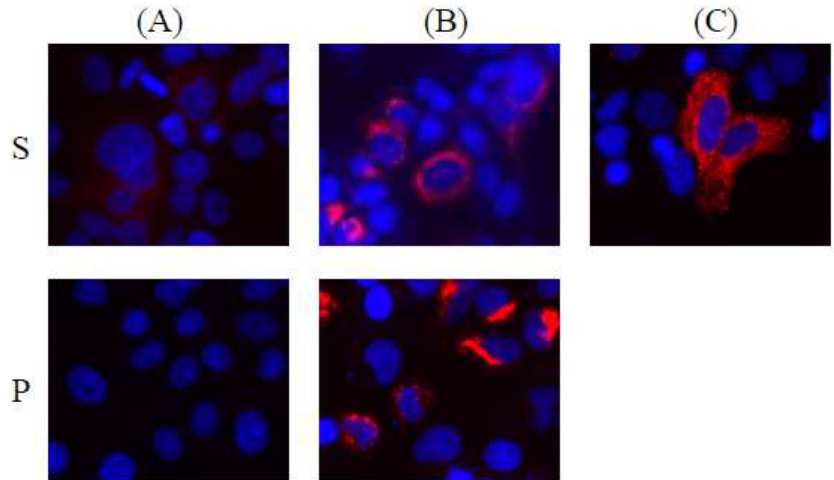
Figure 4. Automatic expression of proteins of HBV integrants from chromosomes 3 and 11. Representative images are shown (40 × ). Fluorescent immunostaining for HBsAg ( S ) and HBV polymerase ( P ) in PLC / PRF / 5 cells ( A ), Huh7 cells transfected with the pCR-Blunt II-TOPO-HBV integrant from chromosome 3 ( B ), or Huh7 cells transfected with the pCR-Blunt II-TOPO-HBV integrant from chromosome 11 ( C ).